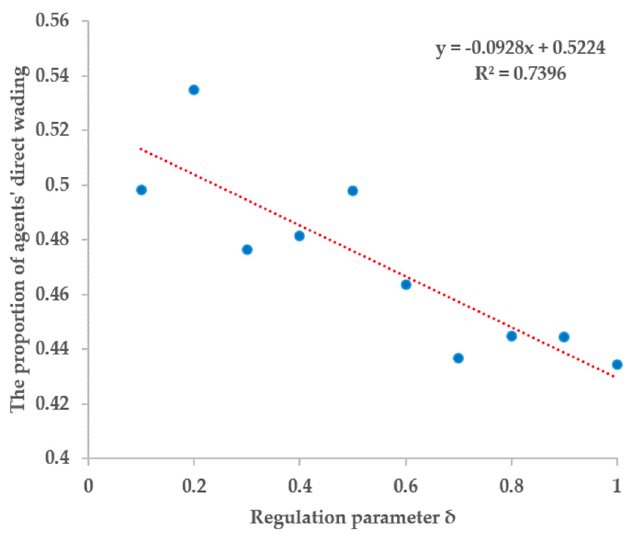
Figure 12. Influences of δ on individuals’ behavior.